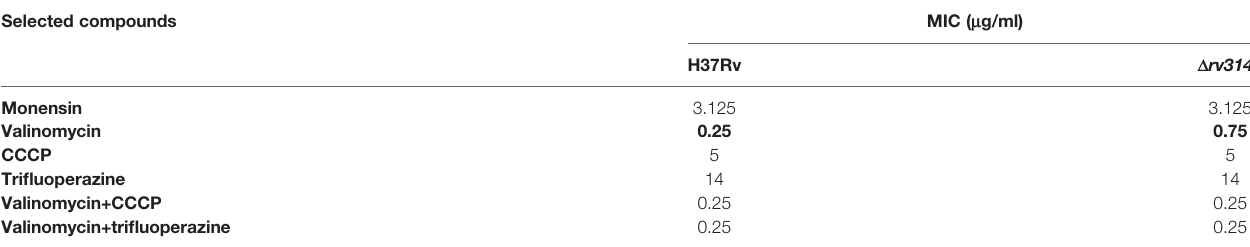
The presented MIC values were obtained repeatable in three biological repeats. The bold numbers represent the difference in MIC value between control H37Rv and mutant strain.